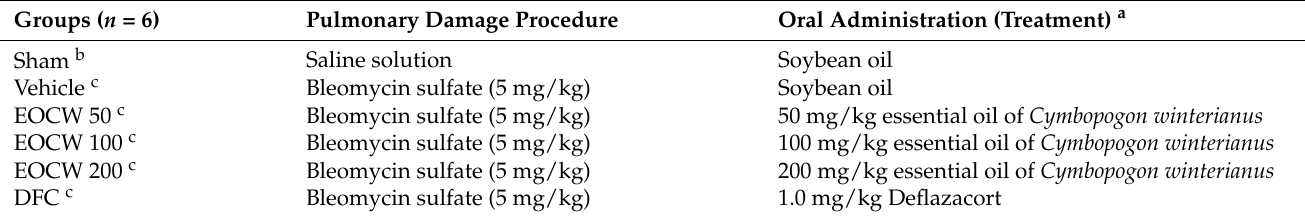
Table 1. Distribution of animals in experimental groups according to